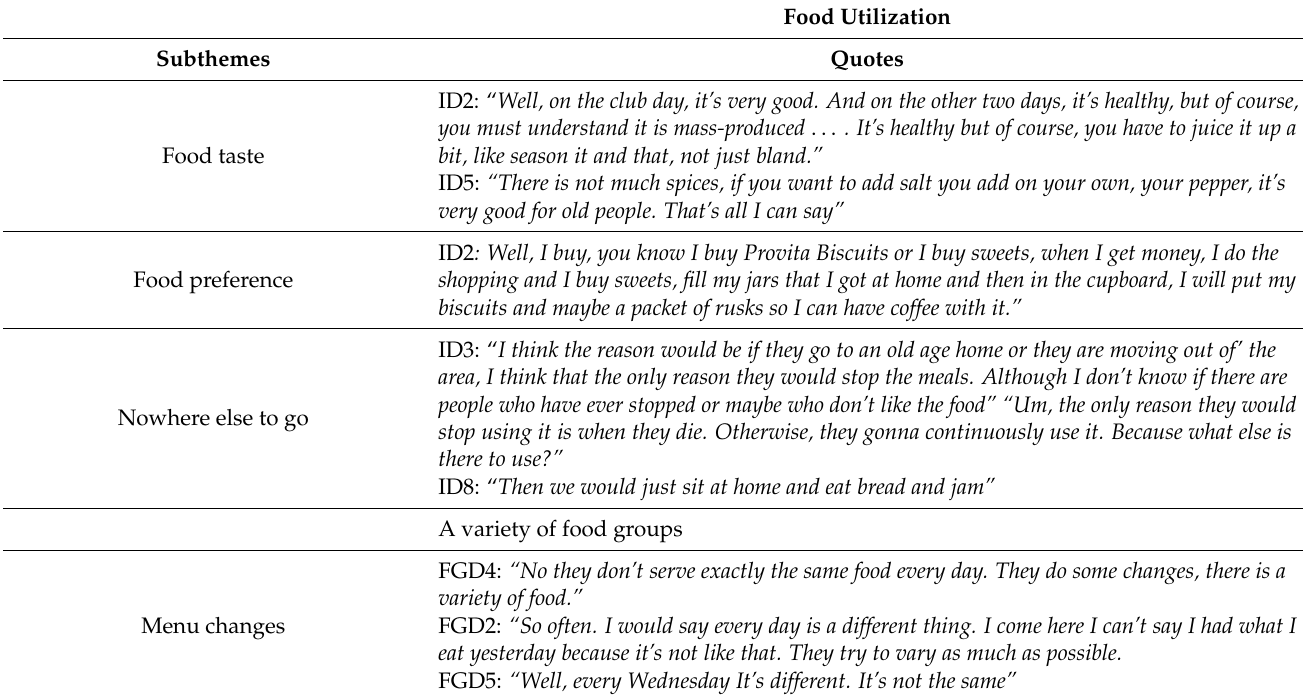
Table 6. Outcomes of food utilization and dietary diversity obtained from the in-depth interviews, key personnel, and focus group